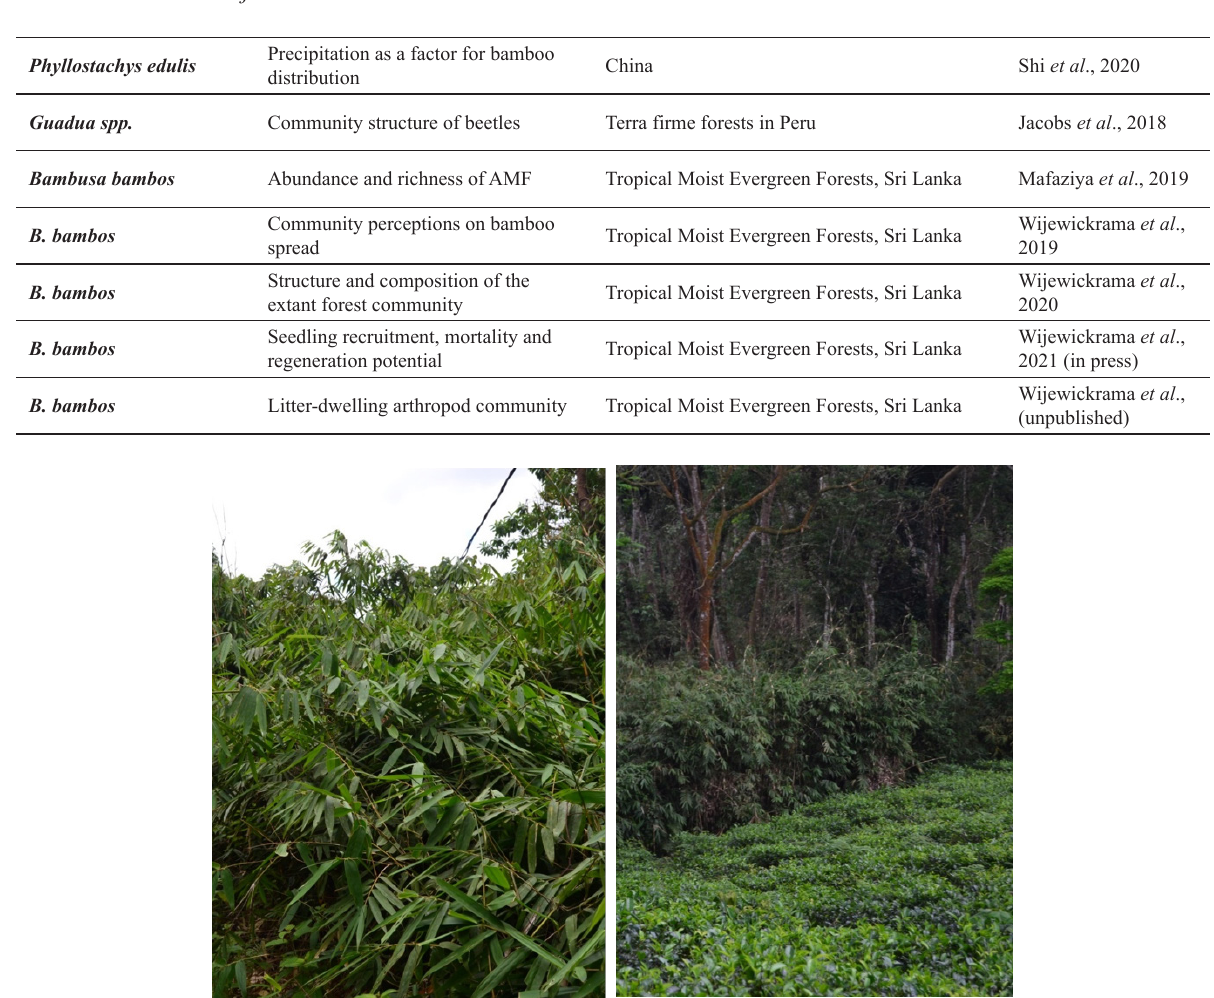
Figure 1: Ochlandra stridula , an endemic bamboo species in Sri Lanka and in the Western Ghats in India, showing a tendency to expand its populations in forests in the lowland wet zone of Sri Lanka. © Tharanga